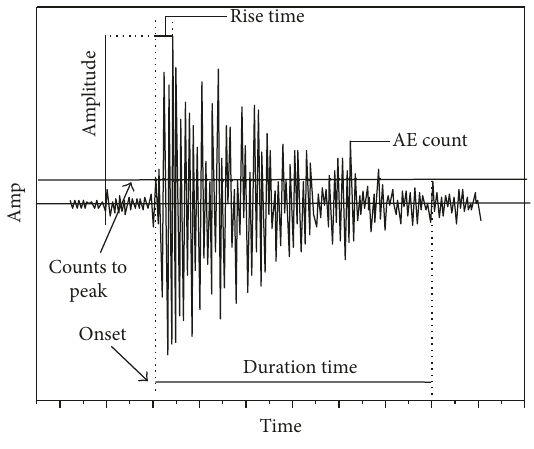
Figure 2: Acoustic emission